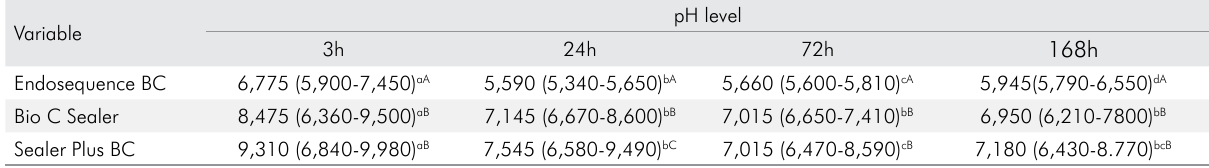
Table 3. Median, minimum and maximum pH values of studied materials in the different experimental periods. Variable